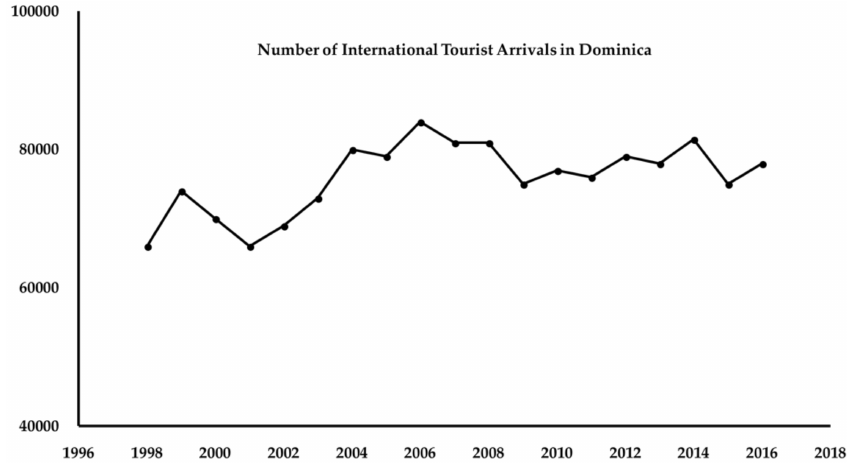
Figure 3. International tourist arrivals to Dominica. Source: World Bank, May